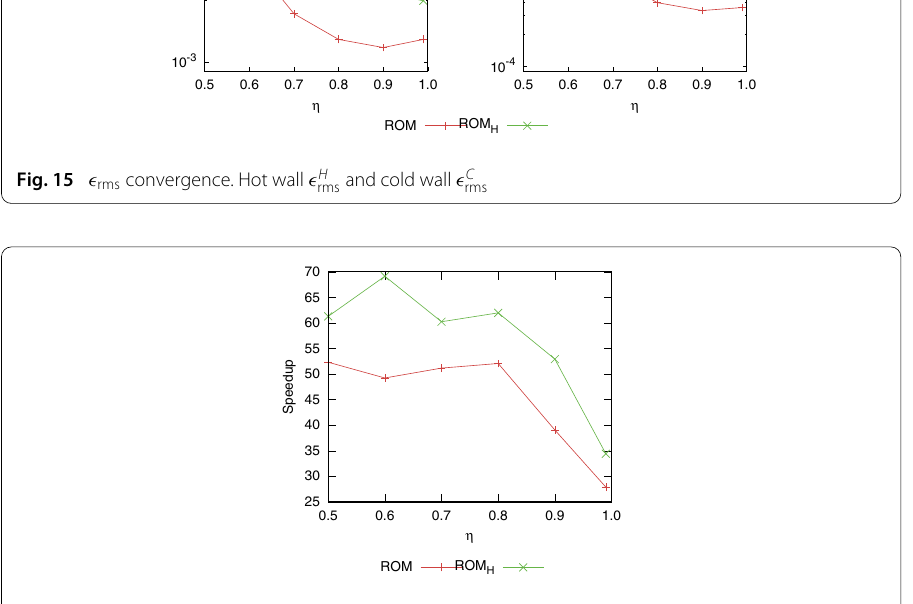
Fig. 16 Speedup for ROM and